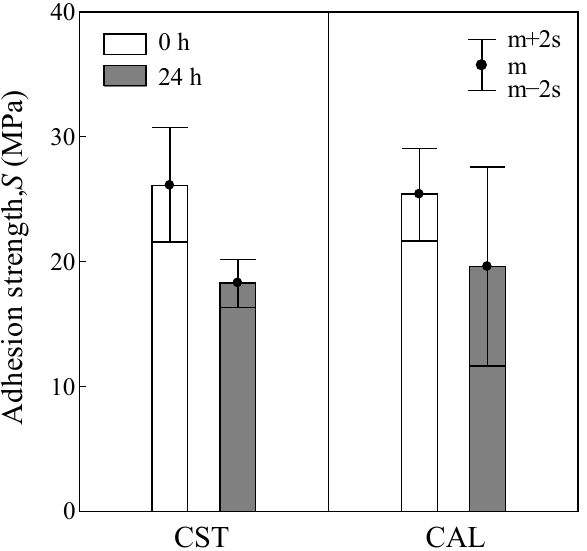
Figure 19. The results of adhesion strength.